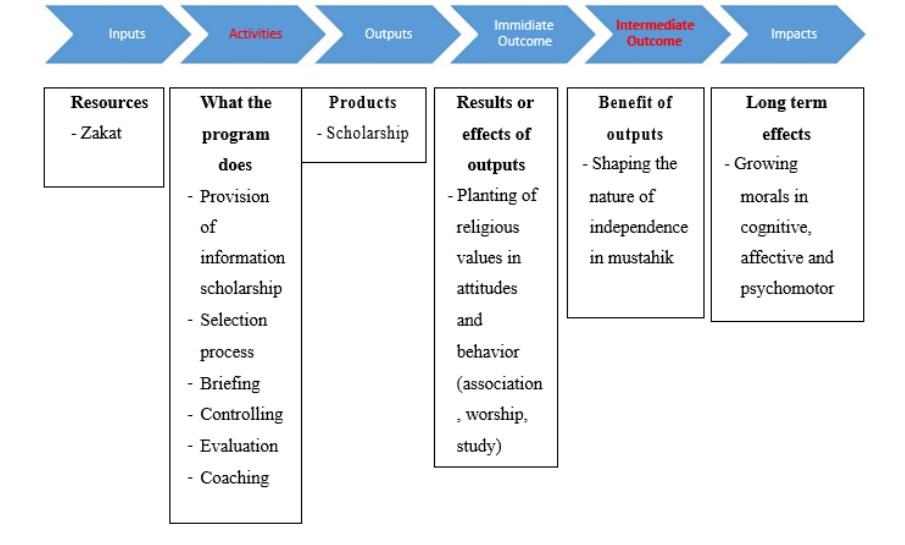
Figure 3 Result Chain Flowchart of Rumah Amal Salman